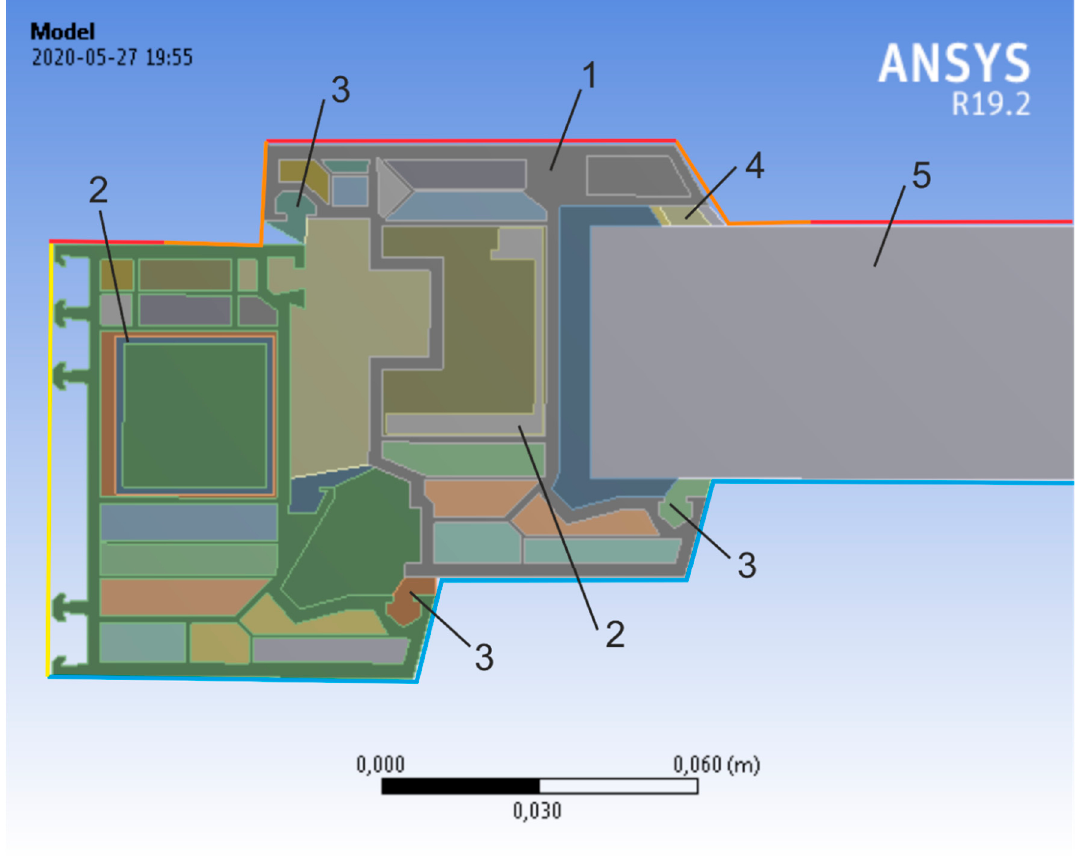
Figure 1. Model of real PVC frame with the following materials: 1, PVC; 2, steel; 3, ethylene-propylene diene monomer (EPDM); 4, butyl rubber; 5, insulation panel. Colored lines define the boundary conditions. Table 1. Material thermal